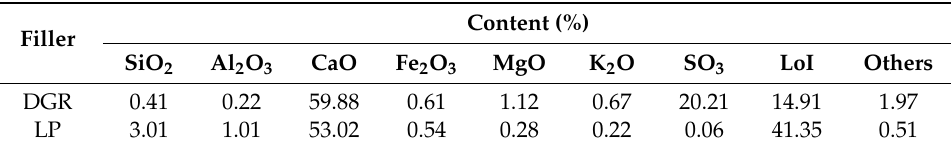
Table 5. Average chemical compositions of DGR and LP.